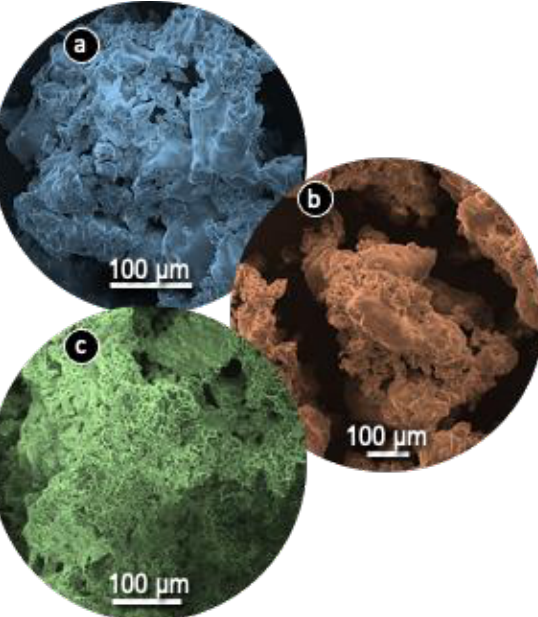
Figure 3. SEM images of tea-leaf-derived material (TEA(char)-AC) ( a ), plane-tree-leaf-derived ma- terial (PL(char)-AC) ( b ), and TEA-AC ( c ). material (PL(char)-AC) ( b ), and TEA-AC ( c